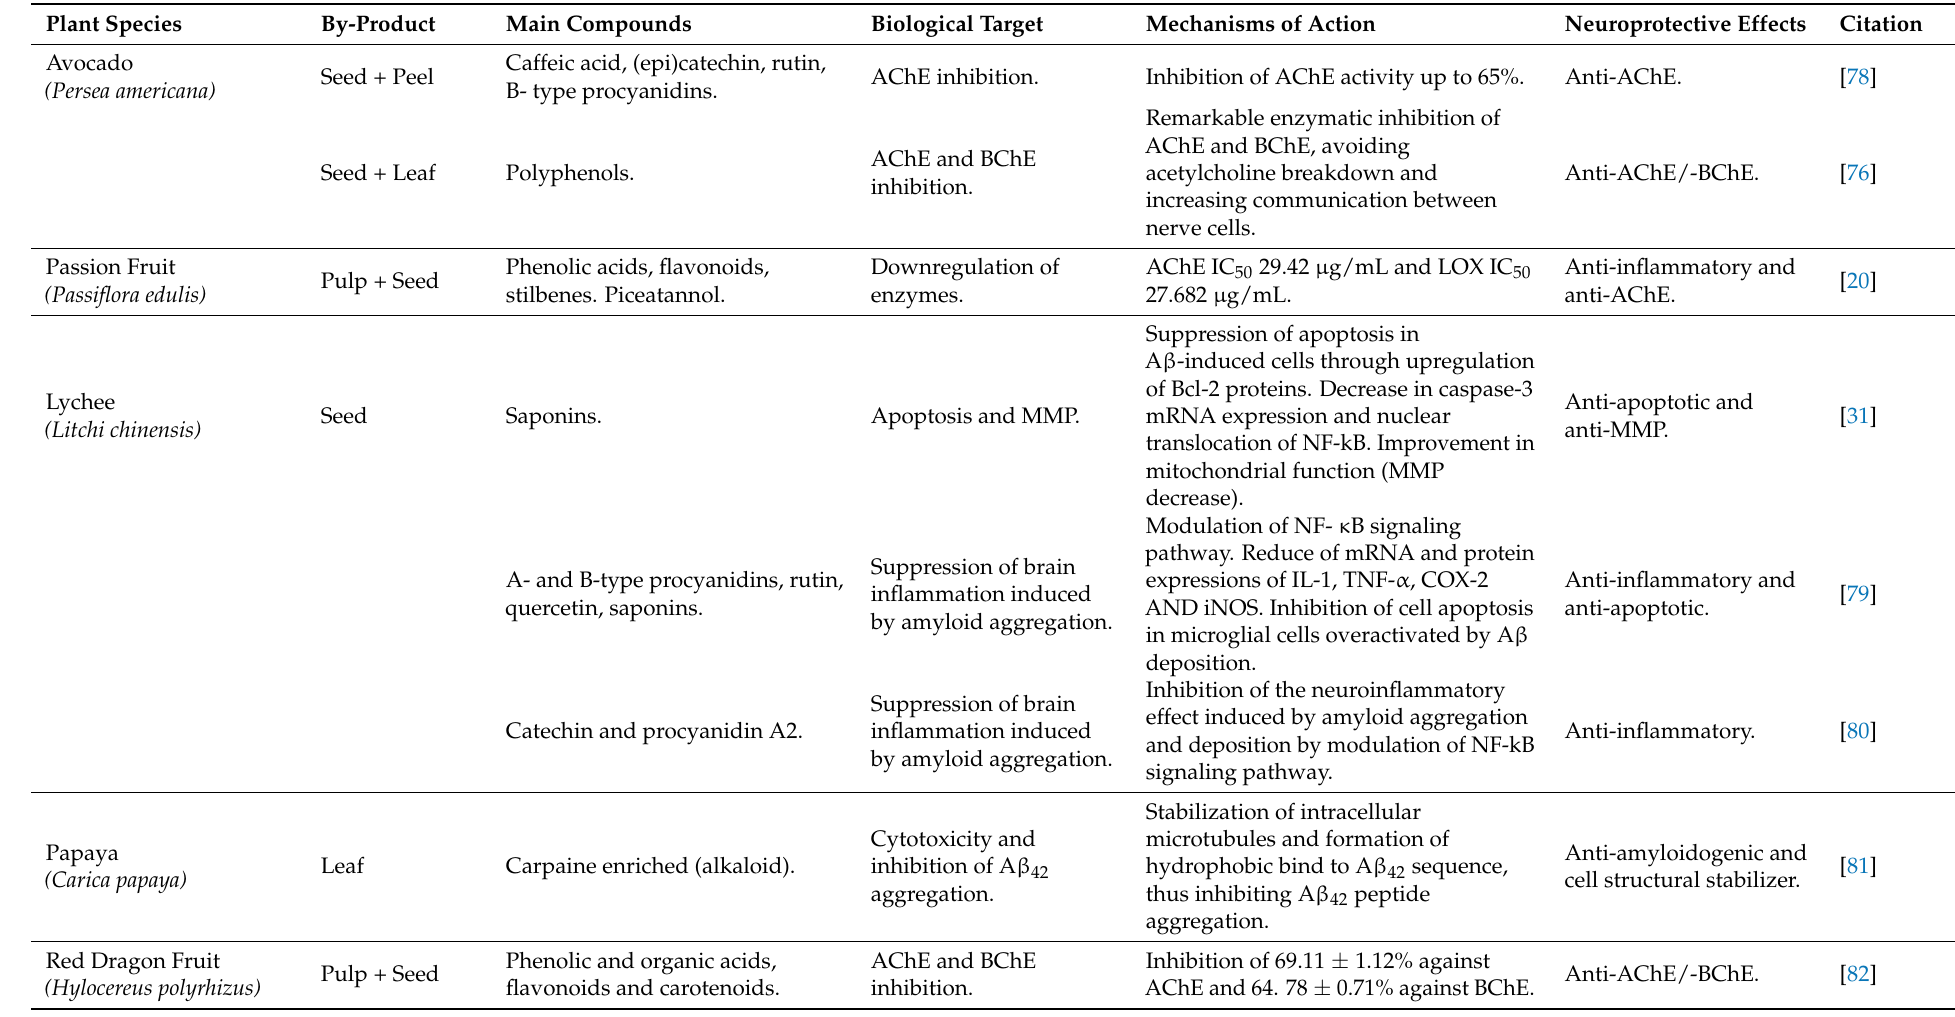
Table 1. Different in vitro studies where fruit and vegetable by-product extracts rich in phenolic compounds (and other bioactives) were tested in neurodegenerative